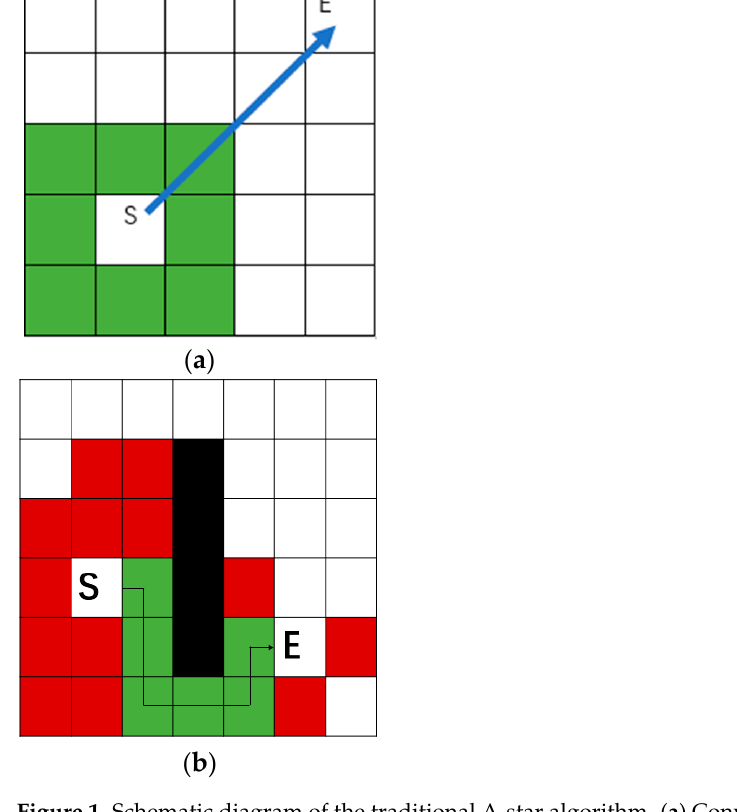
Figure 1. Schematic diagram of the traditional A-star algorithm. ( a ) Conventional A-star algorithm pathfinding in the absence of obstacles; ( b ) conventional A-star algorithm pathfinding in the presence of obstacles.